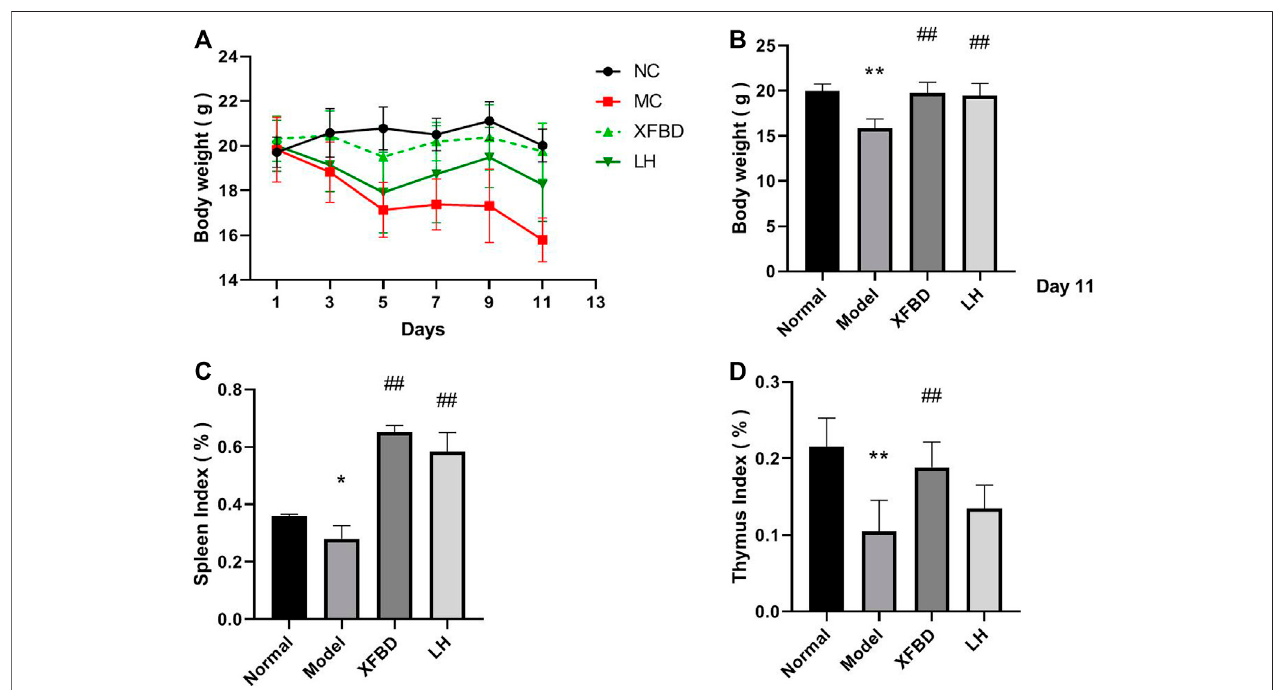
FIGURE1| EffectofXFBDonbodyweightsandimmuneorganindices. (A) Bodyweightsduringtreatment; (B) bodyweightsaftertreatment; (C) spleenindex,and (D) thymus index. Normal, administered with saline; Model: intraperitoneally administered with cyclophosphamide; XFBD: intraperitoneally administered with cyclophosphamide fi rstandfollowedbyXFBDat3.9 g/kg/day;andLH:intraperitoneallyadministeredwithcyclophosphamide fi rstandfollowedbyLHat20 mg/kg.Data are expressed as mean ± SD ( n (cid:2) 6).* p < 0.05 and ** p < 0.01 vs. Normal group, # p < 0.05 and ## p < 0.01 vs. Model group.